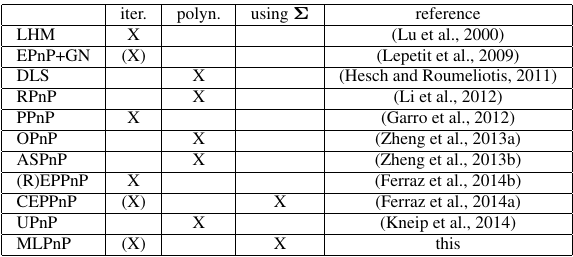
Table 1. Comparison of all tested methods. The methods are categorized into being iterative or a polynomial solver and if they incorporate measurement uncertainty Σ . (X) depicts methods, that refine a preliminary result